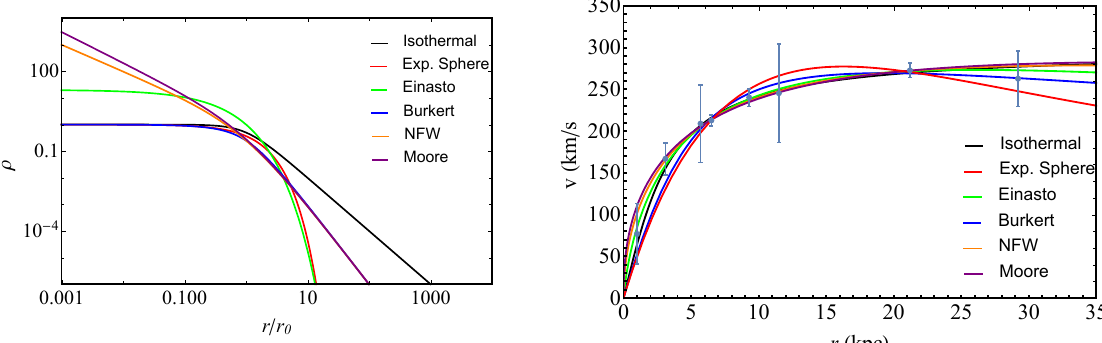
Figure 1. Color online. Left panel: Different phenomenological DM density profiles and we choose α = 1.5 for the Einasto profile. Right panel: RCs of galaxy ESO0140040 and fitted